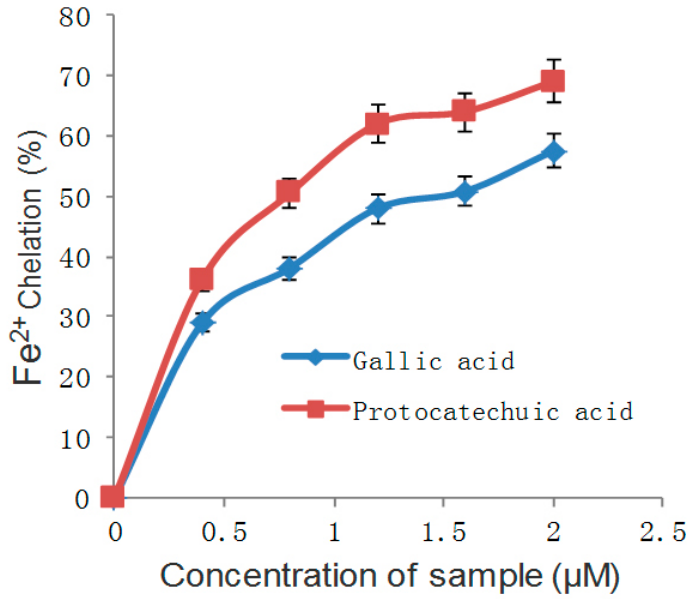
Figure 5. Fe 2+ chelating ability of gallic and protocatechuic acids.